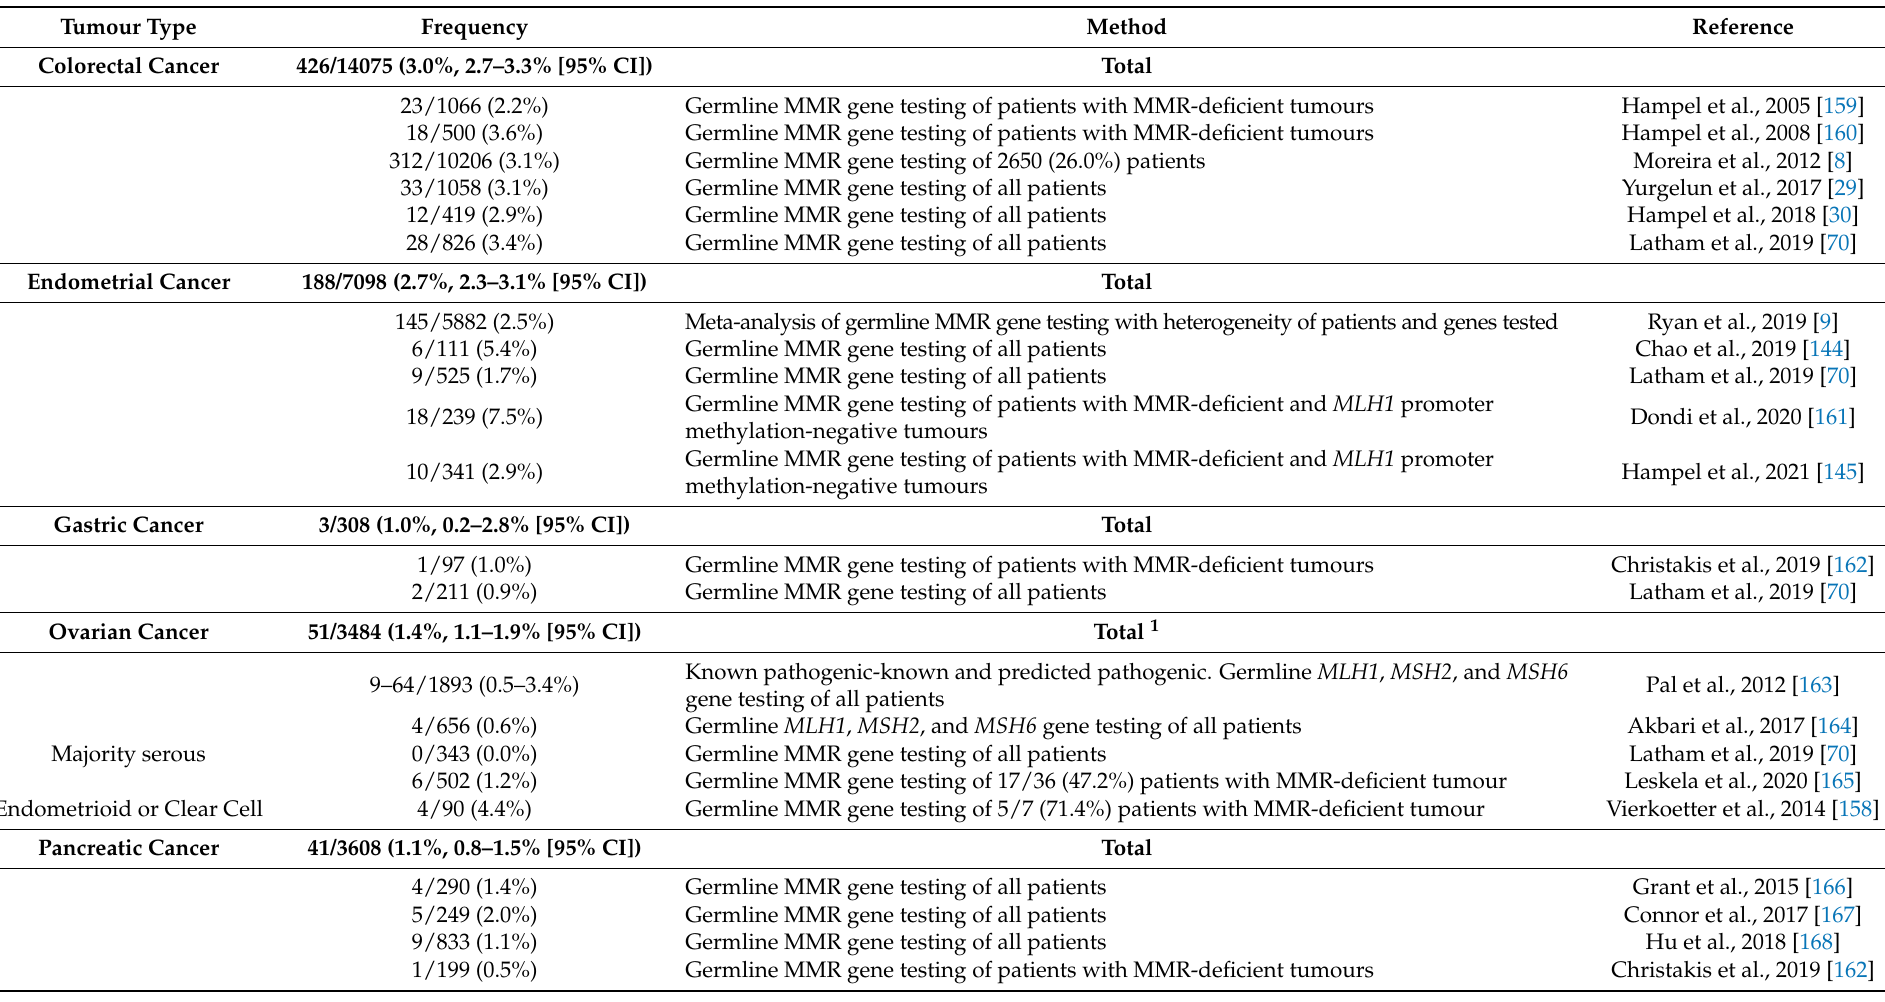
Table 1. Estimated frequency of Lynch syndrome (LS) among unselected patients of different Lynch-spectrum, and other, tumour types. Unselected means no selection of patient by clinical features, such as age or family history. However, some studies selected patients for germline MMR gene testing by tumour MMR deficiency